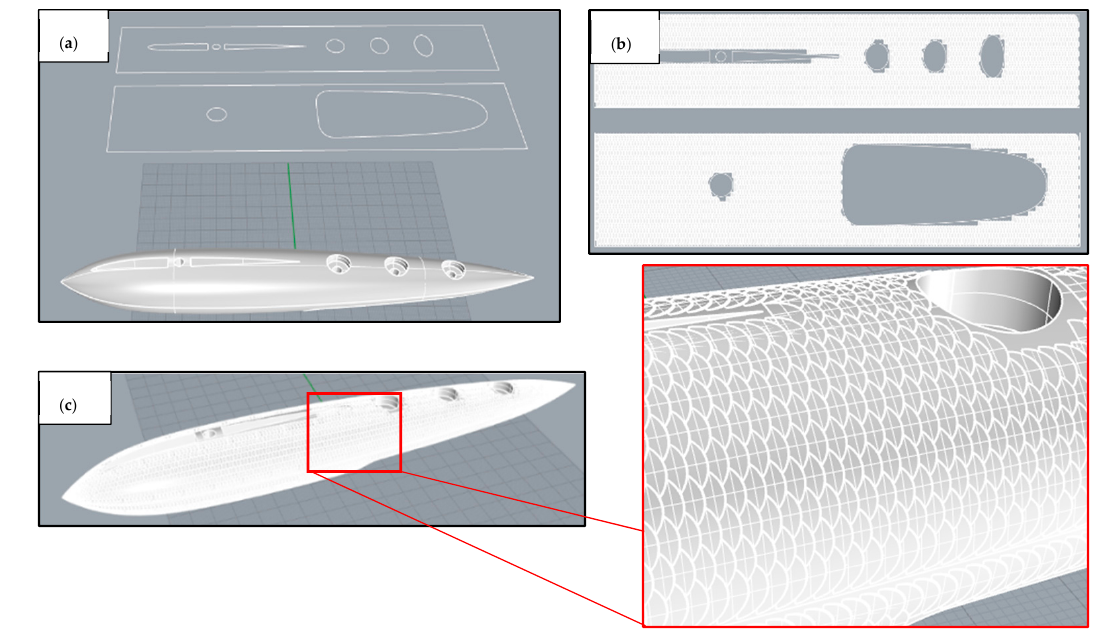
Figure A6. Scale application on bulb external surface; ( a ) reference half-surfaces, ( b ) prepared planar scale pattern for “flow along surface”, ( c ) applied scales. The overall longitudinal length of the component is 290 mm.